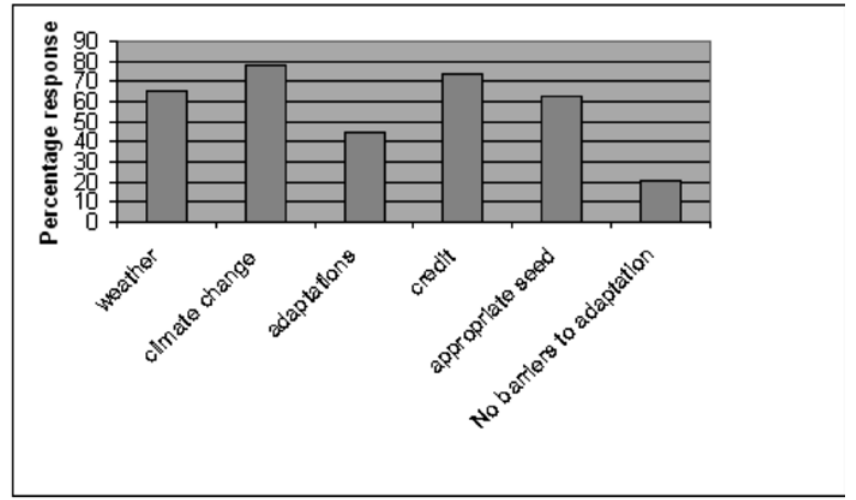
Fig 7. Information concerning climate change forecasting and adaptation options among farmers